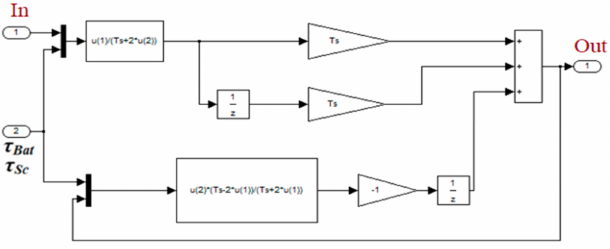
Figure 10. Principle of low-pass filters time constants variation in real time